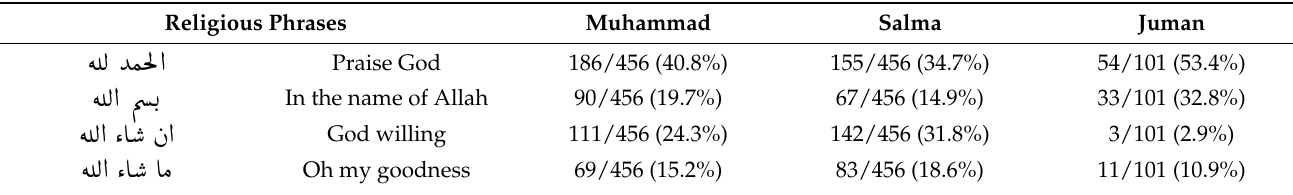
Table 5. Percentage of participants’ speech distribution of religious